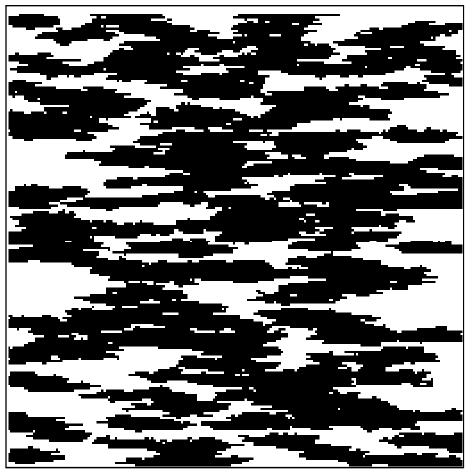
Figure 25. Schematic diagram of quartet structure generation set.